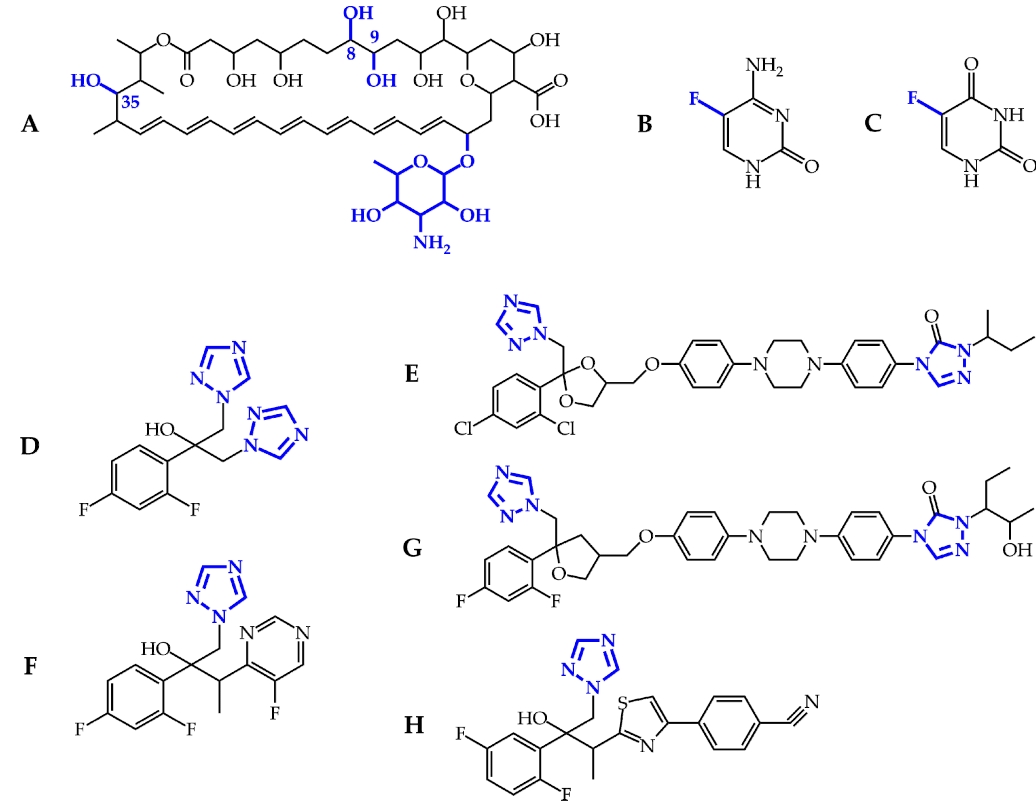
Figure 2. Chemical structures of the licensed antifungal drugs: amphotericin B ( A ); flucytosine ( B ), and its deaminated product 5-fluorouracil ( C ); fluconazole ( D ); itraconazole ( E ); voriconazole ( F ); posaconazole ( G ); and isavuconazole ( H ). The substructures necessary for biological activity are in blue.